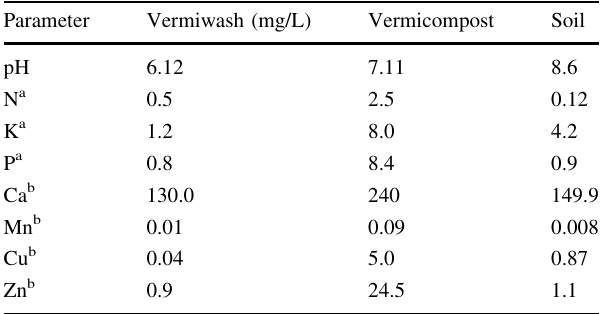
Table 3 Physico-chemical properties of vermiwash, vermicompost and soil Parameter Vermiwash